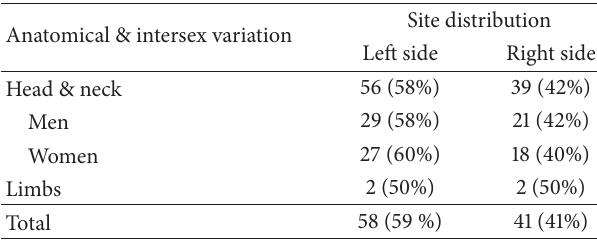
Table 1: Variance in LM lesions anatomical site presentation for side and gender